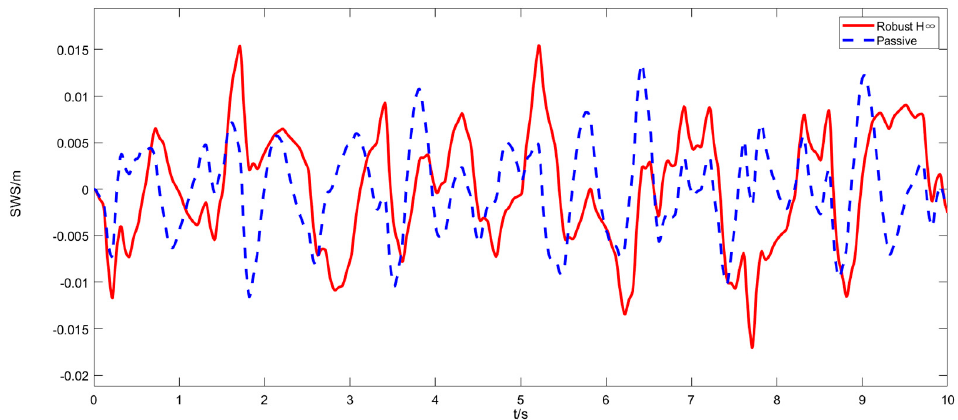
Figure 8. Random road suspension working space responses of passive and active suspensions.